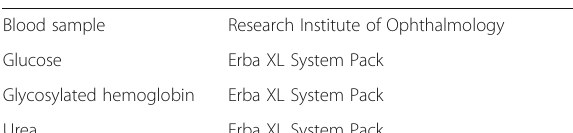
Table 8 Genotype frequency of +405 G/C VEGF in patients with retinopathy phenotypes in both genders +405 VEGF genotype GG CG CC P value Retinopathy type